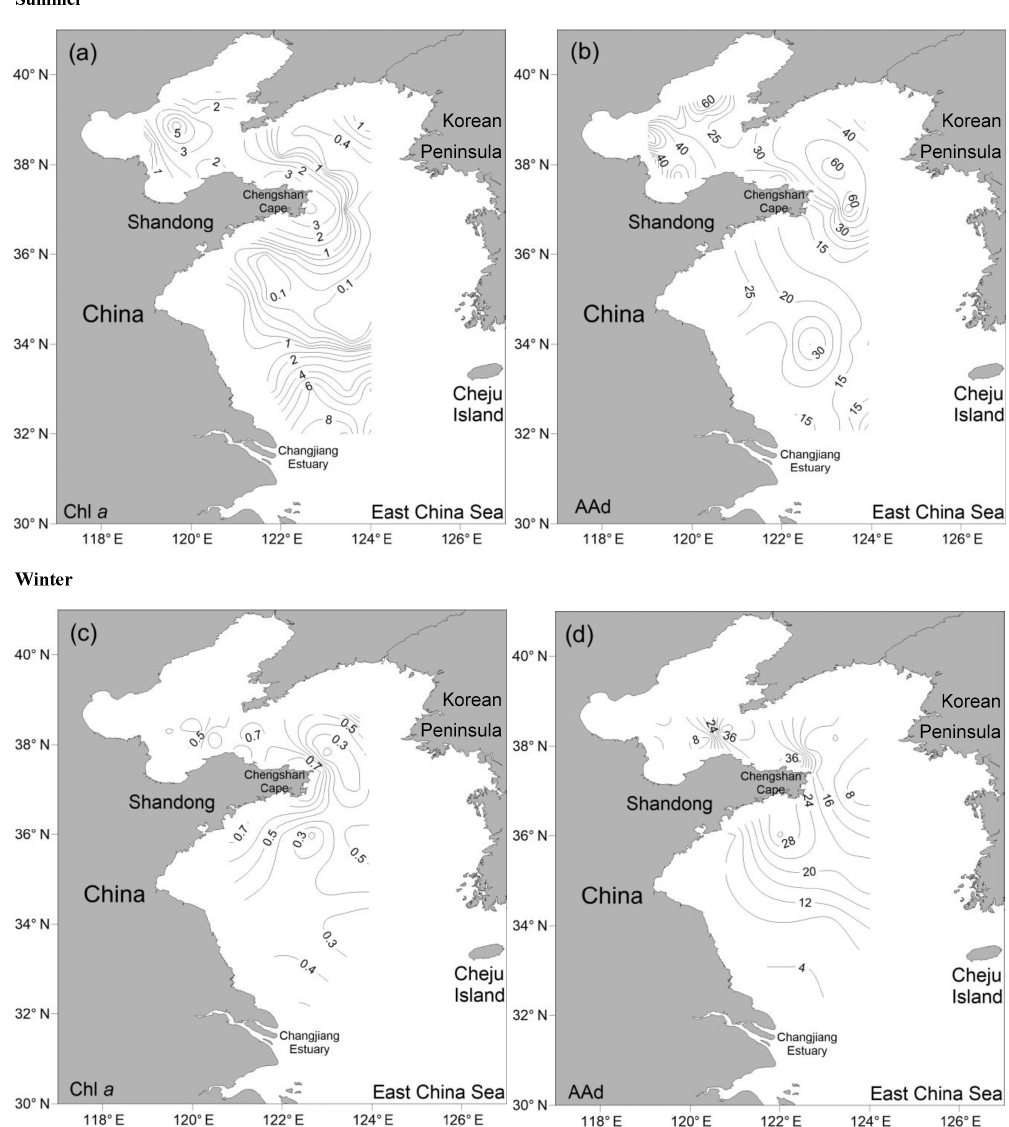
Figure 2. Horizontal distributions of Chl a (µgL − 1 ) and AAd (nmolL − 1 ) in the surface water of the BS and YS during summer and winter. (a) Chl a in summer; (b) AAd in summer; (c) Chl a in winter; (d) AAd in